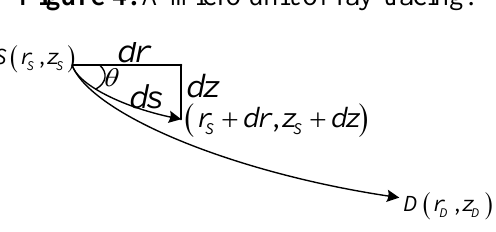
Figure 4. A micro unit of ray